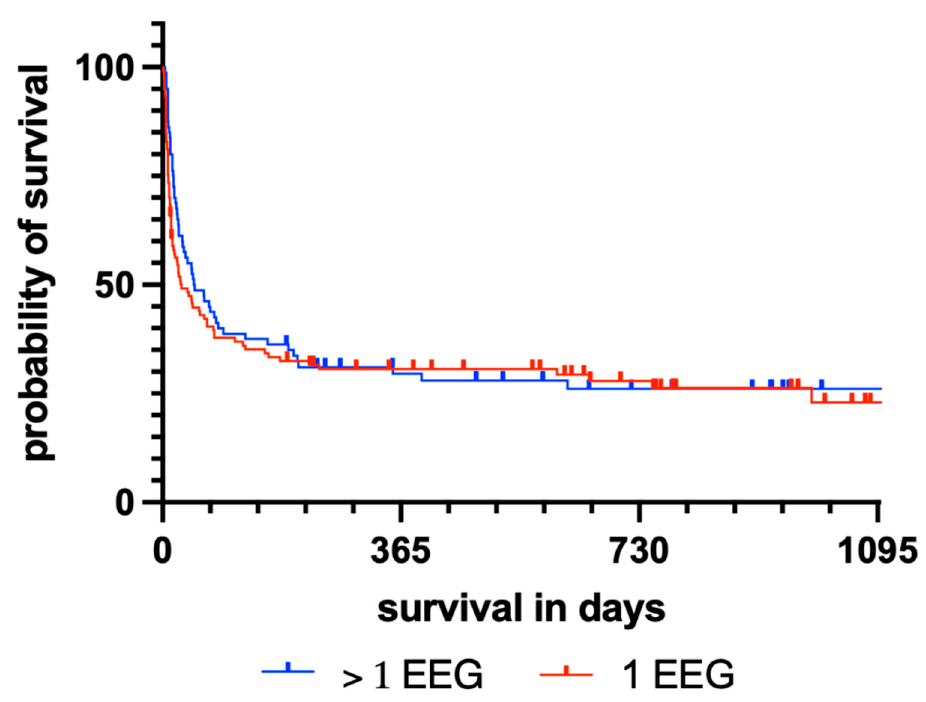
Figure 1. Kaplan–Meier diagram illustrating the survival of HE patients after CPR, taking into consideration the number of derived EEGs.